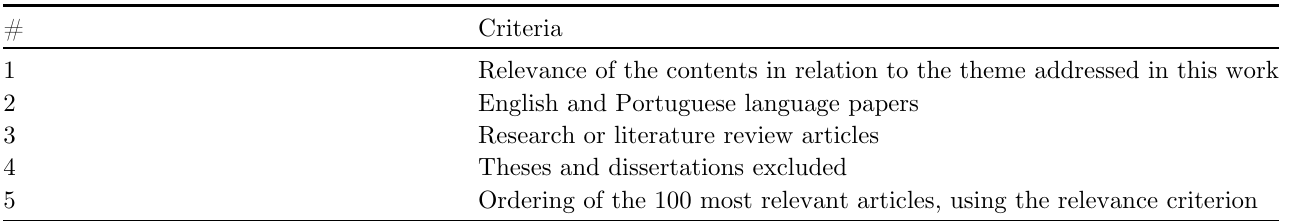
Table 2. Criteria for article selection.